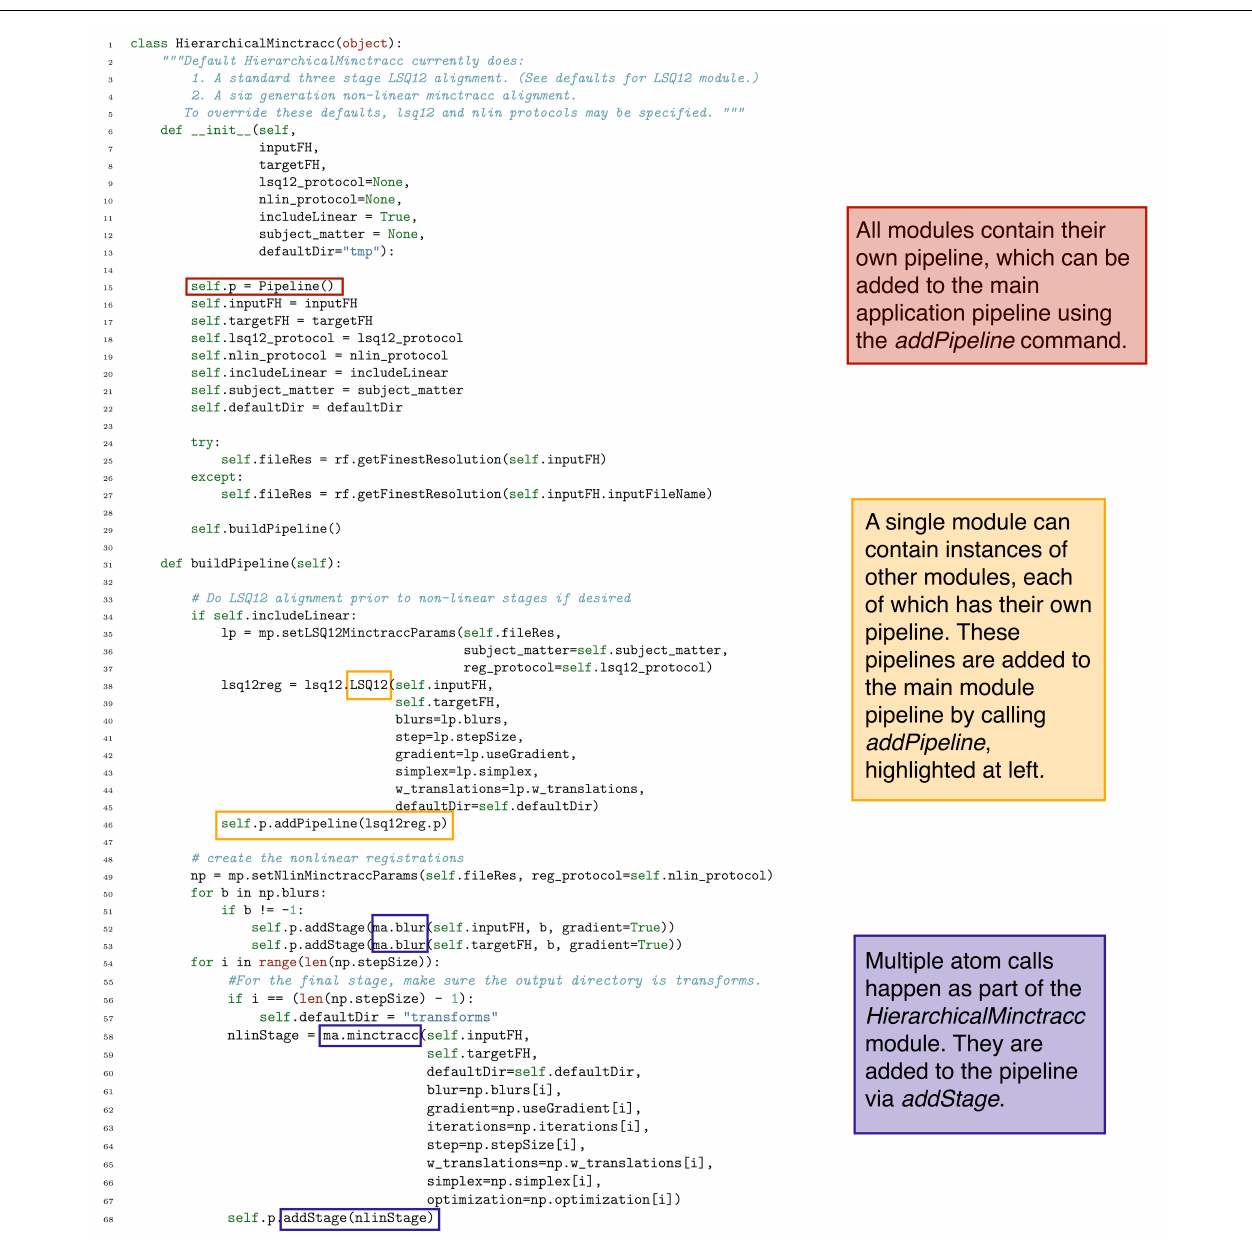
FIGURE 5 | Code snapshot of the HierarchicalMinctracc class. In this class, there are calls to both atoms (e.g., blur and minctracc ) and modules ( LSQ12 ). Note that minctracc is called iteratively, as is shown in Figure 4 , but is using a different subset of